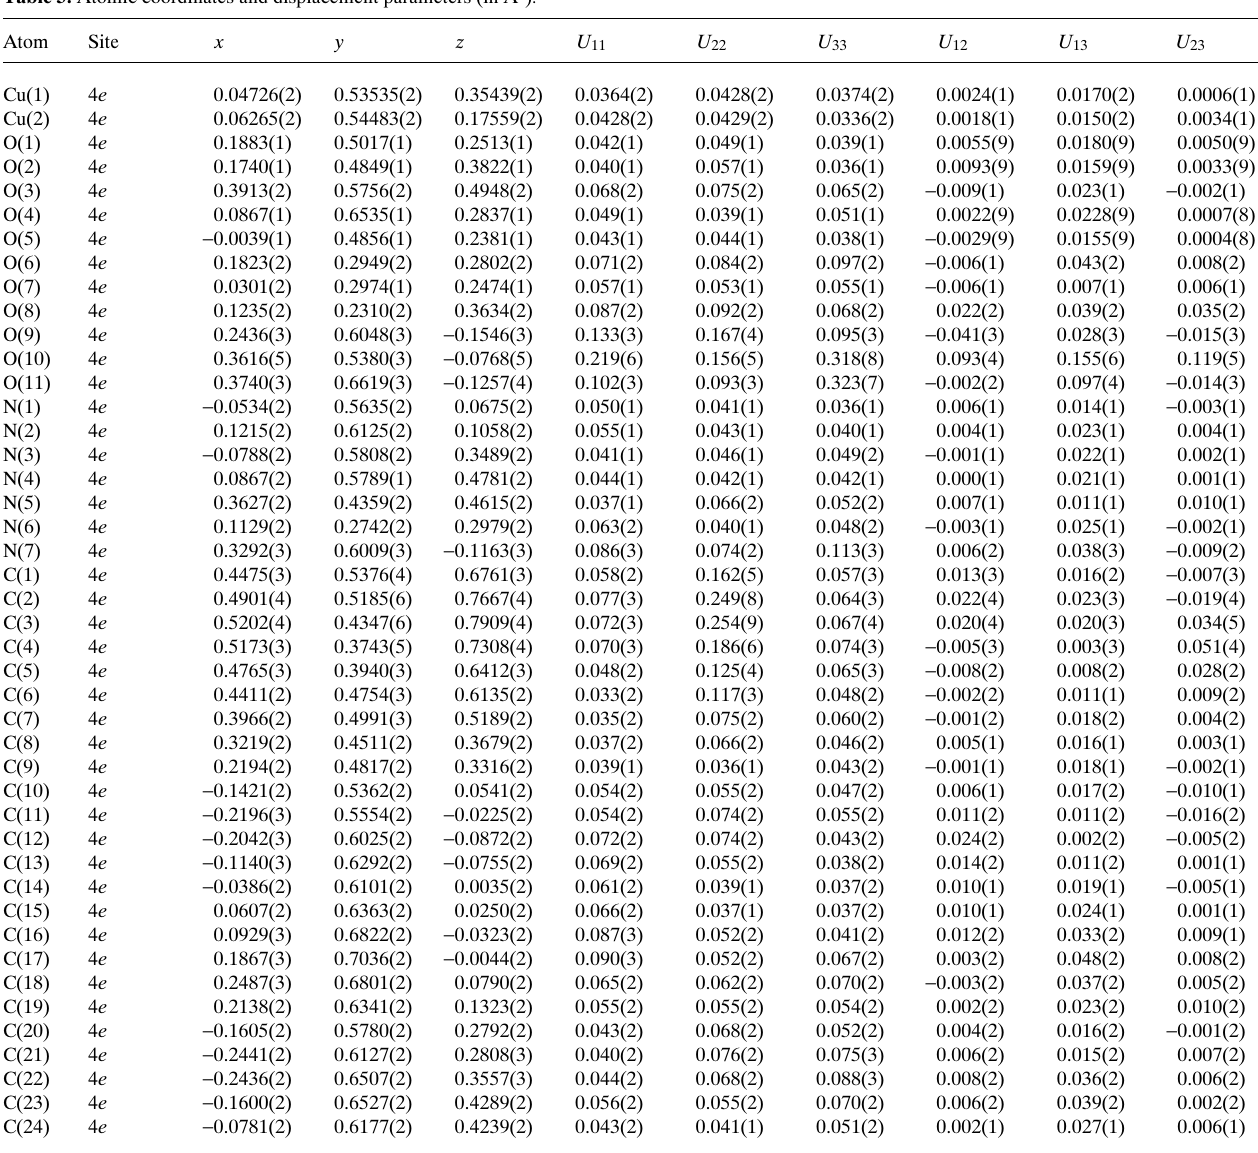
Table 3. Atomic coordinates and displacement parameters (in Å 2 ) .